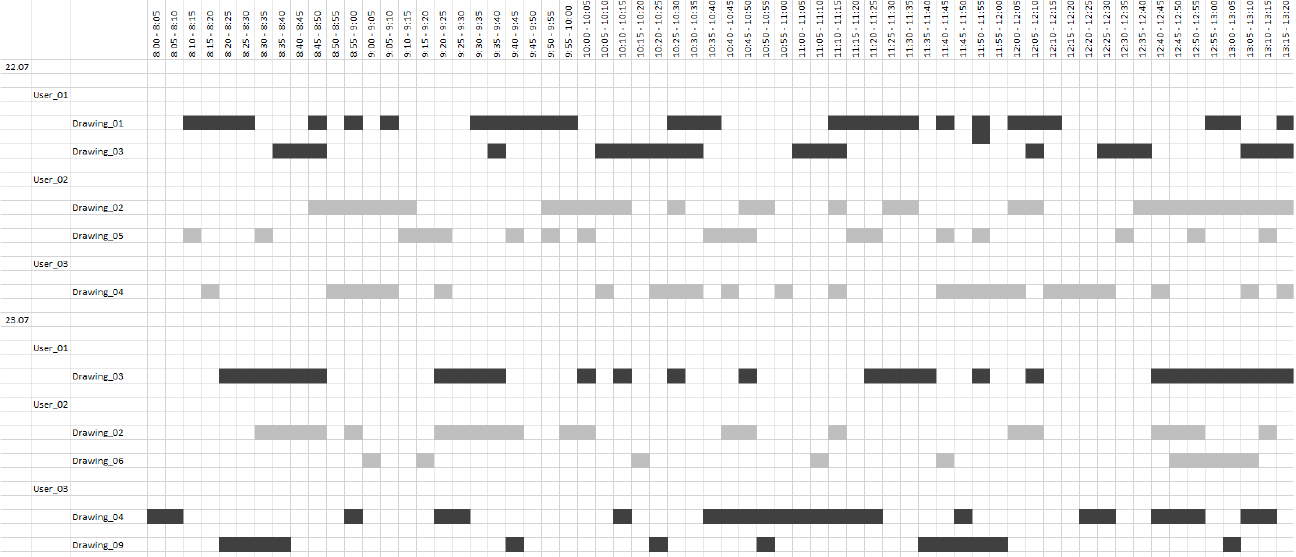
Fig. 3. Visualization of information about working on -line or